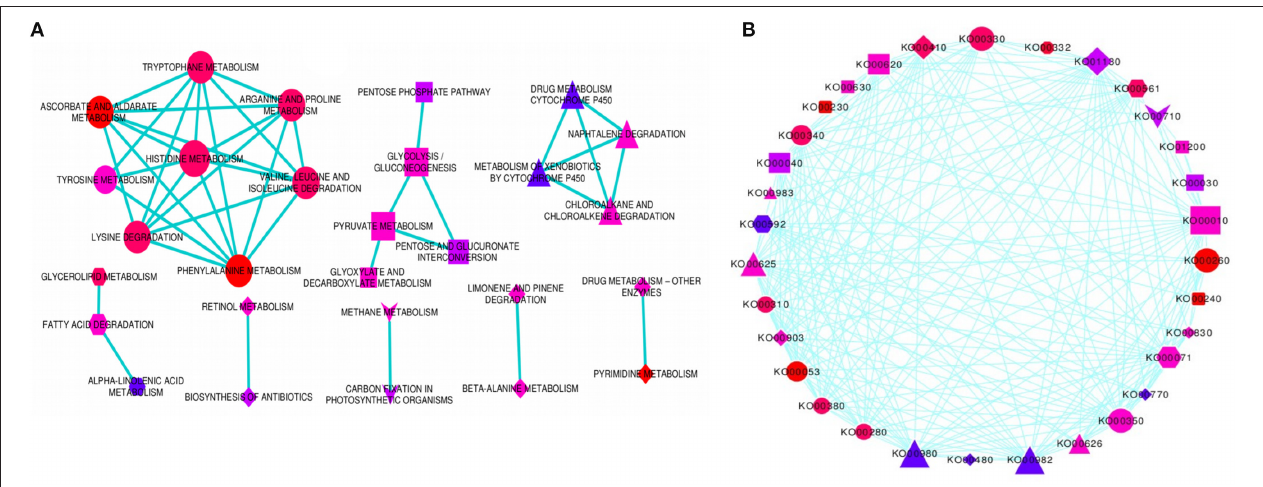
FIGURE 4 | Enriched pathways cross-talk network. The figure shows the enriched pathways cross-talk built based on the gene interaction network for modulated pathways cross-talk network (A) , and the circular pathways cross-talk network (B) . Three major modules and several minor groups of enriched pathways were linked in cross-talk via DRGs interaction network. The pathways involved in circular cross-talk network were represented by their respective ko identifiers as indicated in (B) . Each enriched pathway in the cross-talk contain multiple genes interacting, not < 3. Those pathways with < 3 genes were disregarded. The significance of any two specific pathways overlap was determined using the p -value, FDR < 0.01, as a threshold value, which again limits the size of interacting genes on the cross-talk network. The enriched pathways ( p -value < 0.01) were selected as an entry for cross-talk network. Each node represents enriched pathway and edges denotes pathway-defined cross-talking relations. The size of nodes corresponds to the number of interacting genes involved in each enriched pathway such that the more the number of interacting genes, the larger is the node. The color of the nodes indicates the significance level ( p -value) of pathways overlap, the brighter the color (red), the more significant is the pathways overlap. The shape of the nodes corresponds to functional categories (modules) of the pathways, with circle (ellipse) for amino acid metabolism, rectangle for carbohydrate metabolism, triangle for xenobiotics biodegradation and metabolism, hexagon for lipid metabolism, V (inverted triangle) for carbon and energy metabolism, round rectangle for nucleotide metabolism, diamond for metabolism of co-factors and vitamins, and octagon for biosynthesis of other secondary metabolites. Some of the pathways in the modulated pathway cross-talk are not included in the circular pathway cross-talk.